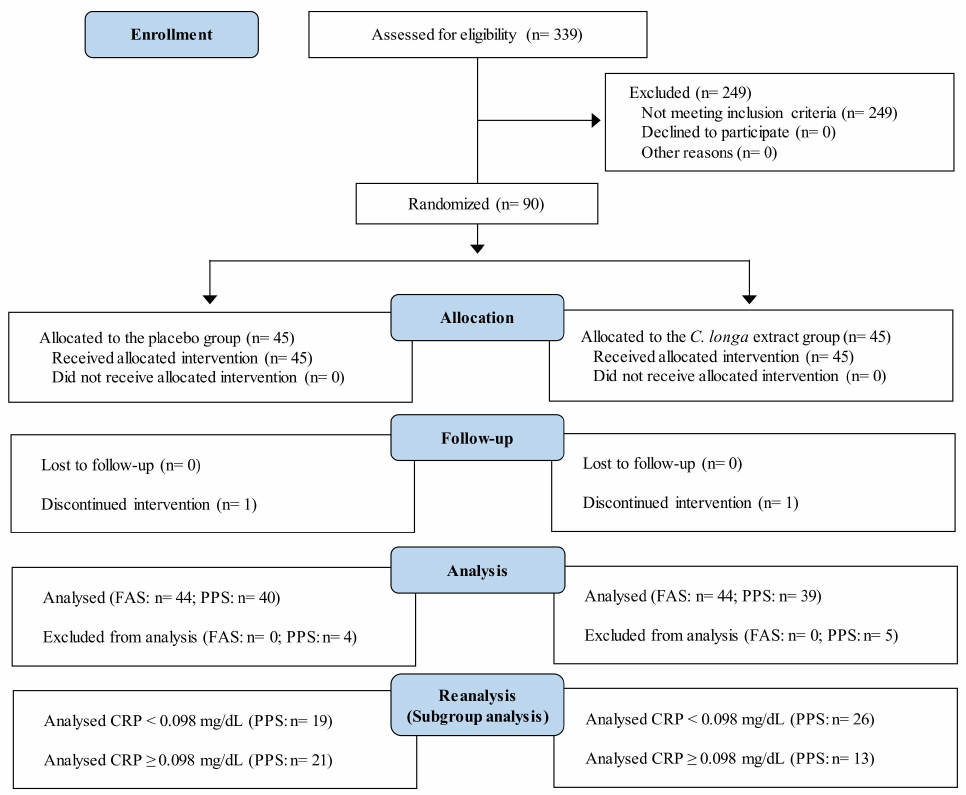
Figure 2. Study flow diagram (CONSORT 2010) in study